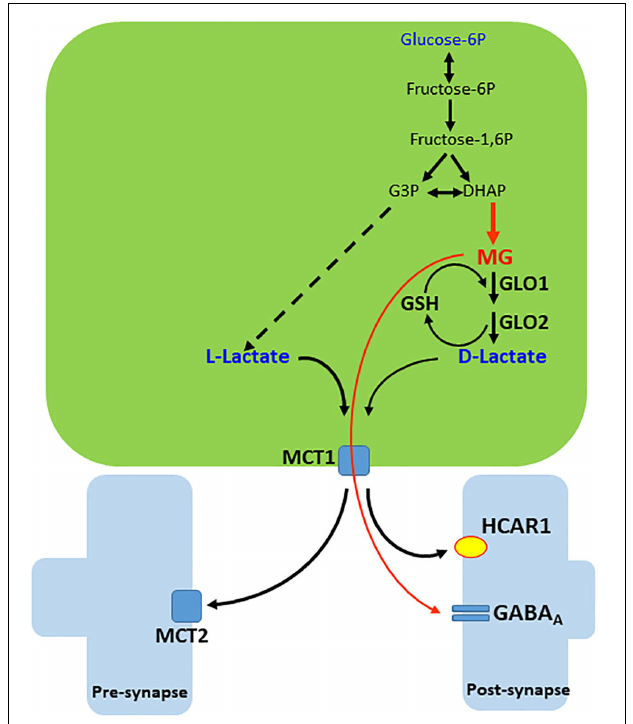
FIGURE 3 | Generation and release of MG and D -lactate in astrocytes. Methylglyoxal (MG) is produced from dihydroxyacetone phosphate (DHAP) by a deviation of the glycolytic pathway. MG is condensed with glutathione (GSH) and then, by sequential action of glyoxalases 1 and 2 (GLO1 and 2), generates D -lactate and recycles GSH. D -lactate leaves the cell via monocarboxylate transporter 1 (MCT1) but disturbs lactate and pyruvate flows to mitochondria (not illustrated). MG and D -lactate leave the cell and act on the GABA A receptor and hydroxy-carboxylic acid receptor 1 (HCAR1), respectively. Extrasynaptic GABA A receptors of MG are not